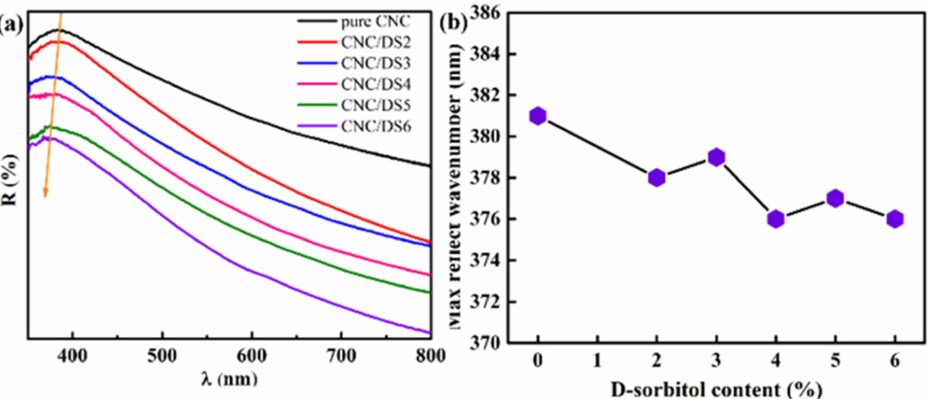
Figure 4. ( a ) UV-Vis spectra of the pure CNC and CNC/DS films, ( b ) relationship between D-sorbitol concentrations and maximum wavelengths of selective reflection of pure CNC and CNC/DS